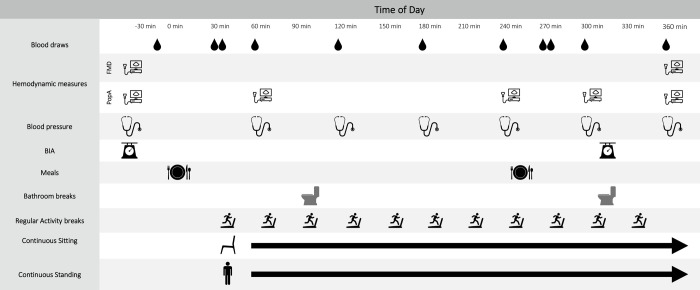
Intervention session timeline.